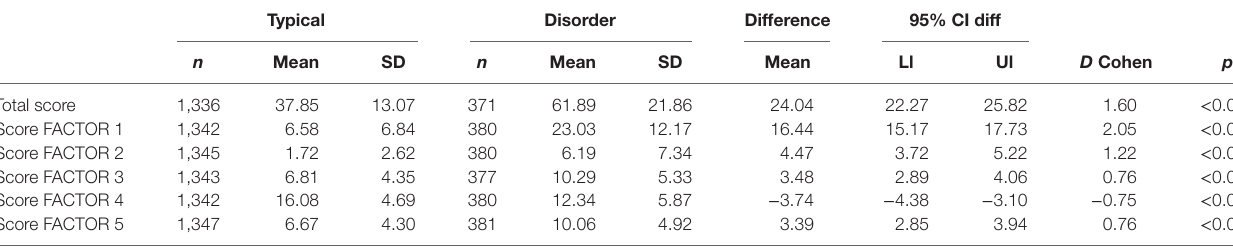
tAble 6 | Average scores of healthy children and children with a disorder. typical